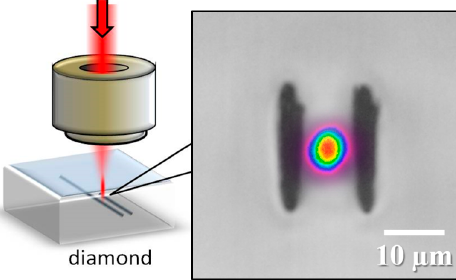
Figure 1. ( Left ) Type II waveguide geometry in diamond where optical mode confinement is achieved between two closely spaced and parallel laser-inscribed modification lines. ( Right ) Transverse view optical microscope image of type II modification in diamond, with modification tracks separated by 13 µ m. The laser processing conditions were 500 kHz repetition rate, 100 nJ pulse energy, and 0.5 mm/s scan speed. The depth of the waveguide track (measured from surface to center of modifications) was 40 µ m. Overlaid mode profile measured at 635 nm wavelength. Guiding could also be observed by translating the input fiber, a few microns above and below this central and highest transmission mode. Note that the color linear scale varying from 0 (violet) to 1 (red) indicates the relative intensity of the mode profile, normalized to the peak